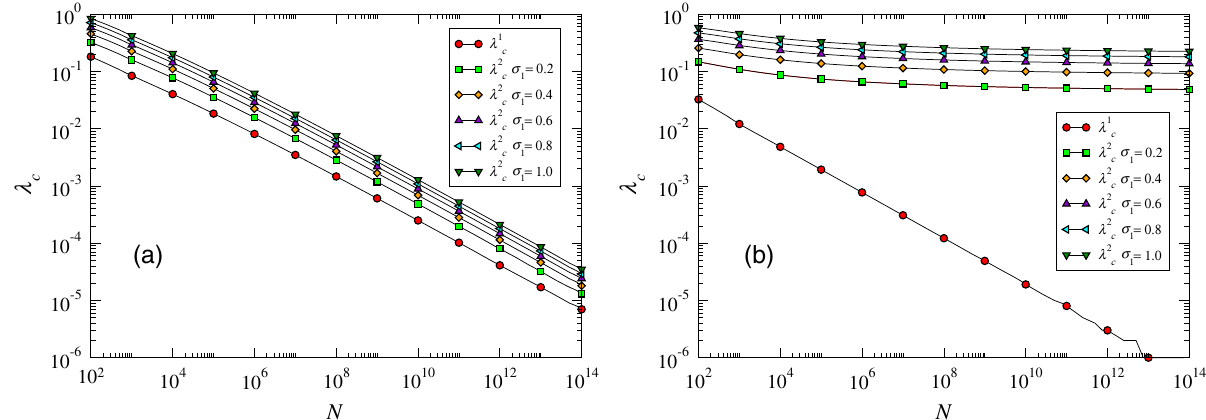
FIG. 5. Primary and secondary threshold values as a function of the size of the systems N for different values of Θ : 0.0 (primary threshold), 0.2, 0.4, 0.6, 0.8, and 1.0. Networks are uncorrelated scale-free graphs (a) without correlations between them or (b) with them fully correlated. Diseases interact according to a full cross-immunity scheme β 1 a ¼ β 2 a ¼ 0 and γ ¼ Γ ¼ 2 . 5 . The rest of the parameters are the same as in Fig.